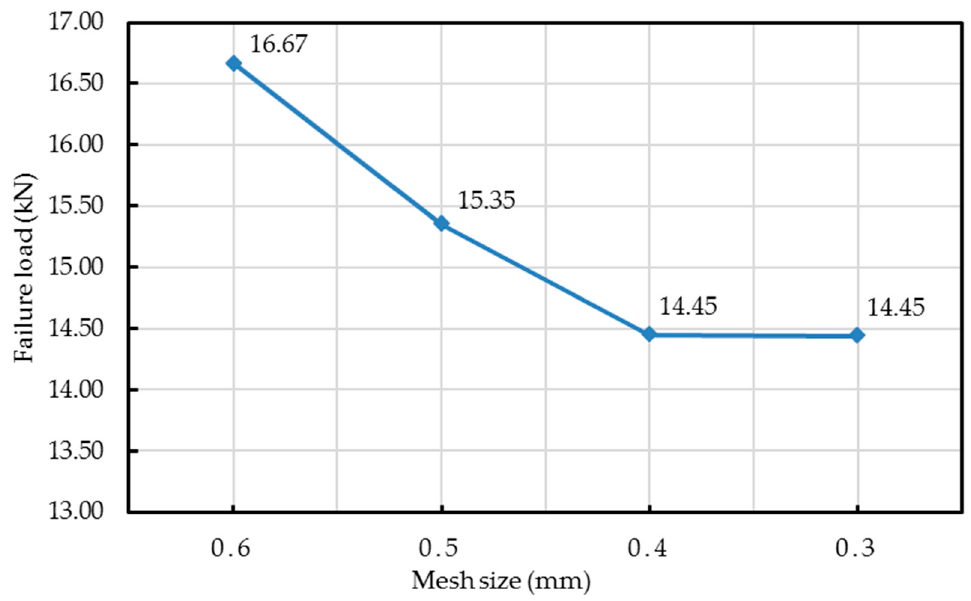
Figure 4. Mesh refinement for the wave induced model (wave severity = 0.075).